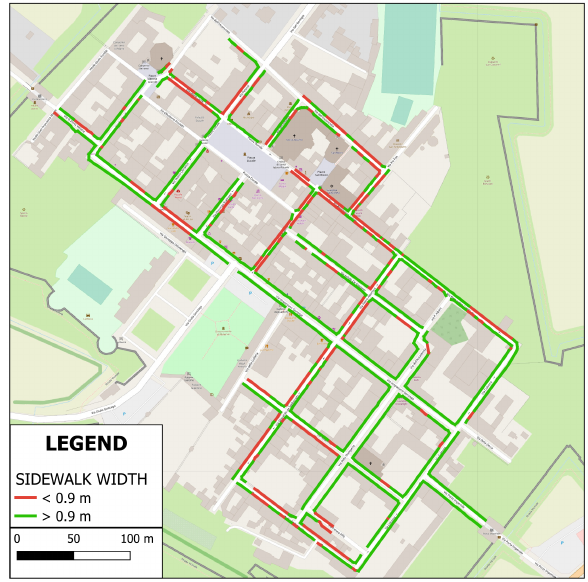
Figure 6. Thematic map of the entire city of Sabbioneta de- veloped using the computed network edges and their attributes. In green sidewalk segments with width > 0.9 m (considered ac- cessible by Italian law) and in red with width < 0.9 m (not access-